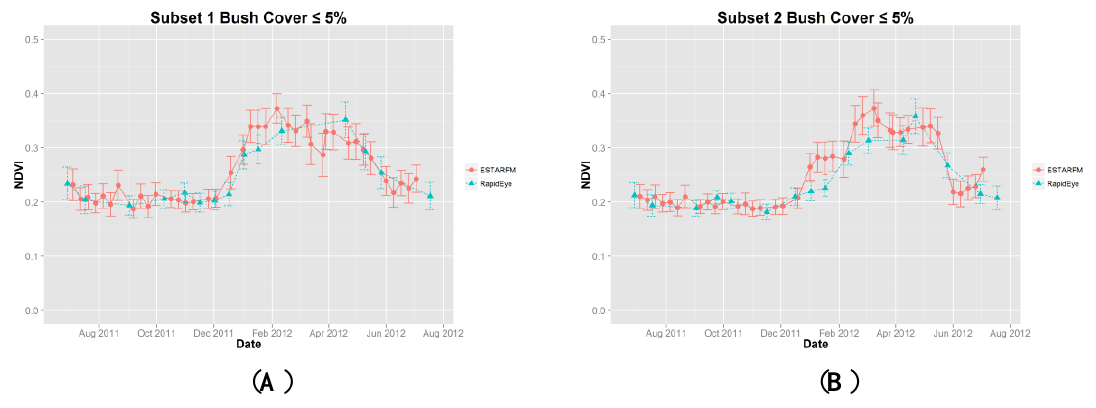
Figure 6. Time series of mean NDVI values calculated for all MODIS pixel size extents classified as containing ≤5% bush cover, derived from RapidEye and synthetic ESTARFM imagery. The error bars represent the standard deviation. ( A ) subset 1; ( B ) subset 2.